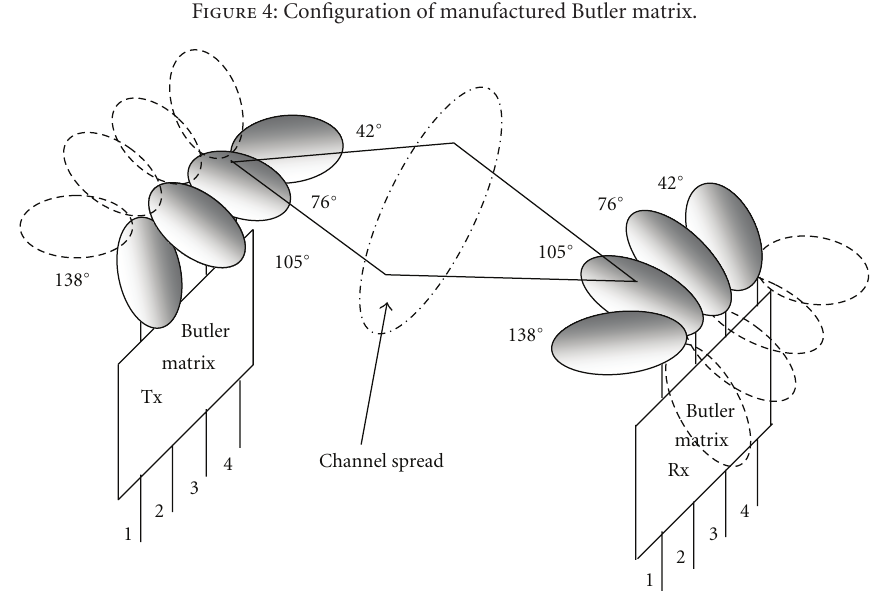
Figure 5: Illustration of applying Butler matrix for 4 × 4 MIMO systems.